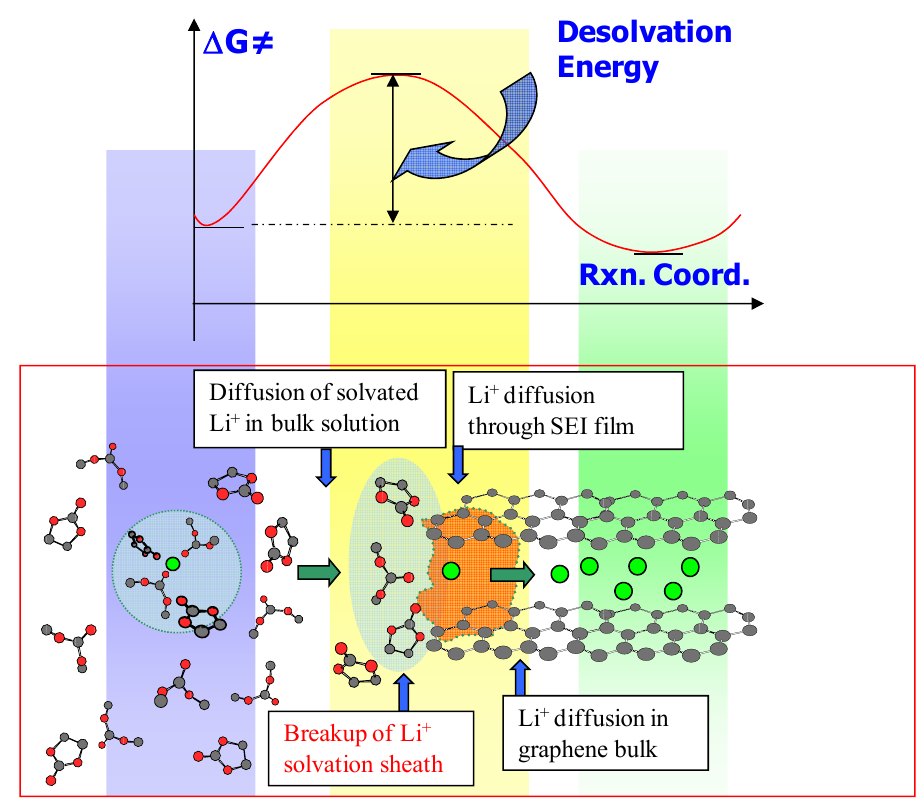
Figure 8. Schematic description of a solvated Li+ diffusing through the formed SEI at electrolyte/graphite interface (below) and the associated energetic